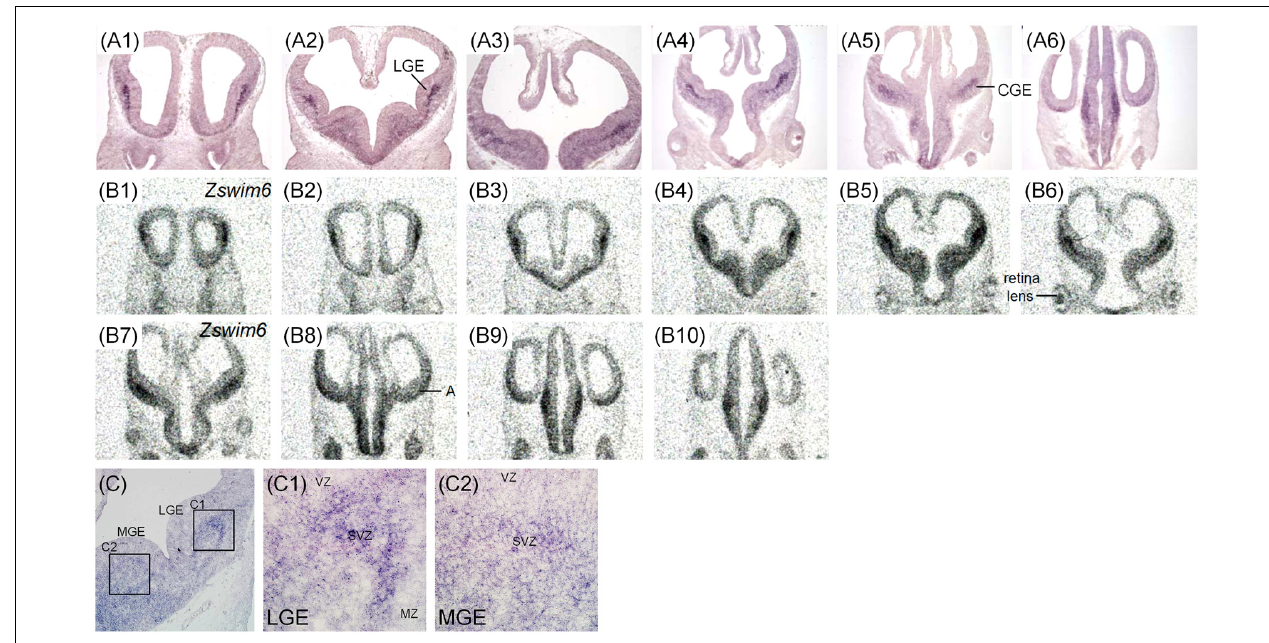
FIGURE 1 | Zswim6 mRNA expression pattern in E11.5 mouse forebrain. Expression pattern of Zswim6 mRNA analyzed by in situ hybridization with digoxigenin-labeled probes (A1–A6) and 35 S-labeled probes (B1–B10) from rostral to caudal levels. (C) Zswim6 is strongly expressed in the SVZ of LGE (C,C1) , but is weaker in the SVZ of MGE (C,C2) . A, amygdala; CGE, caudal ganglionic eminence; LGE, lateral ganglionic eminence; MGE, medial ganglionic eminence; MZ, mantel zone; Sep, septum; SVZ, subventricular zone; VZ, ventricular zone.